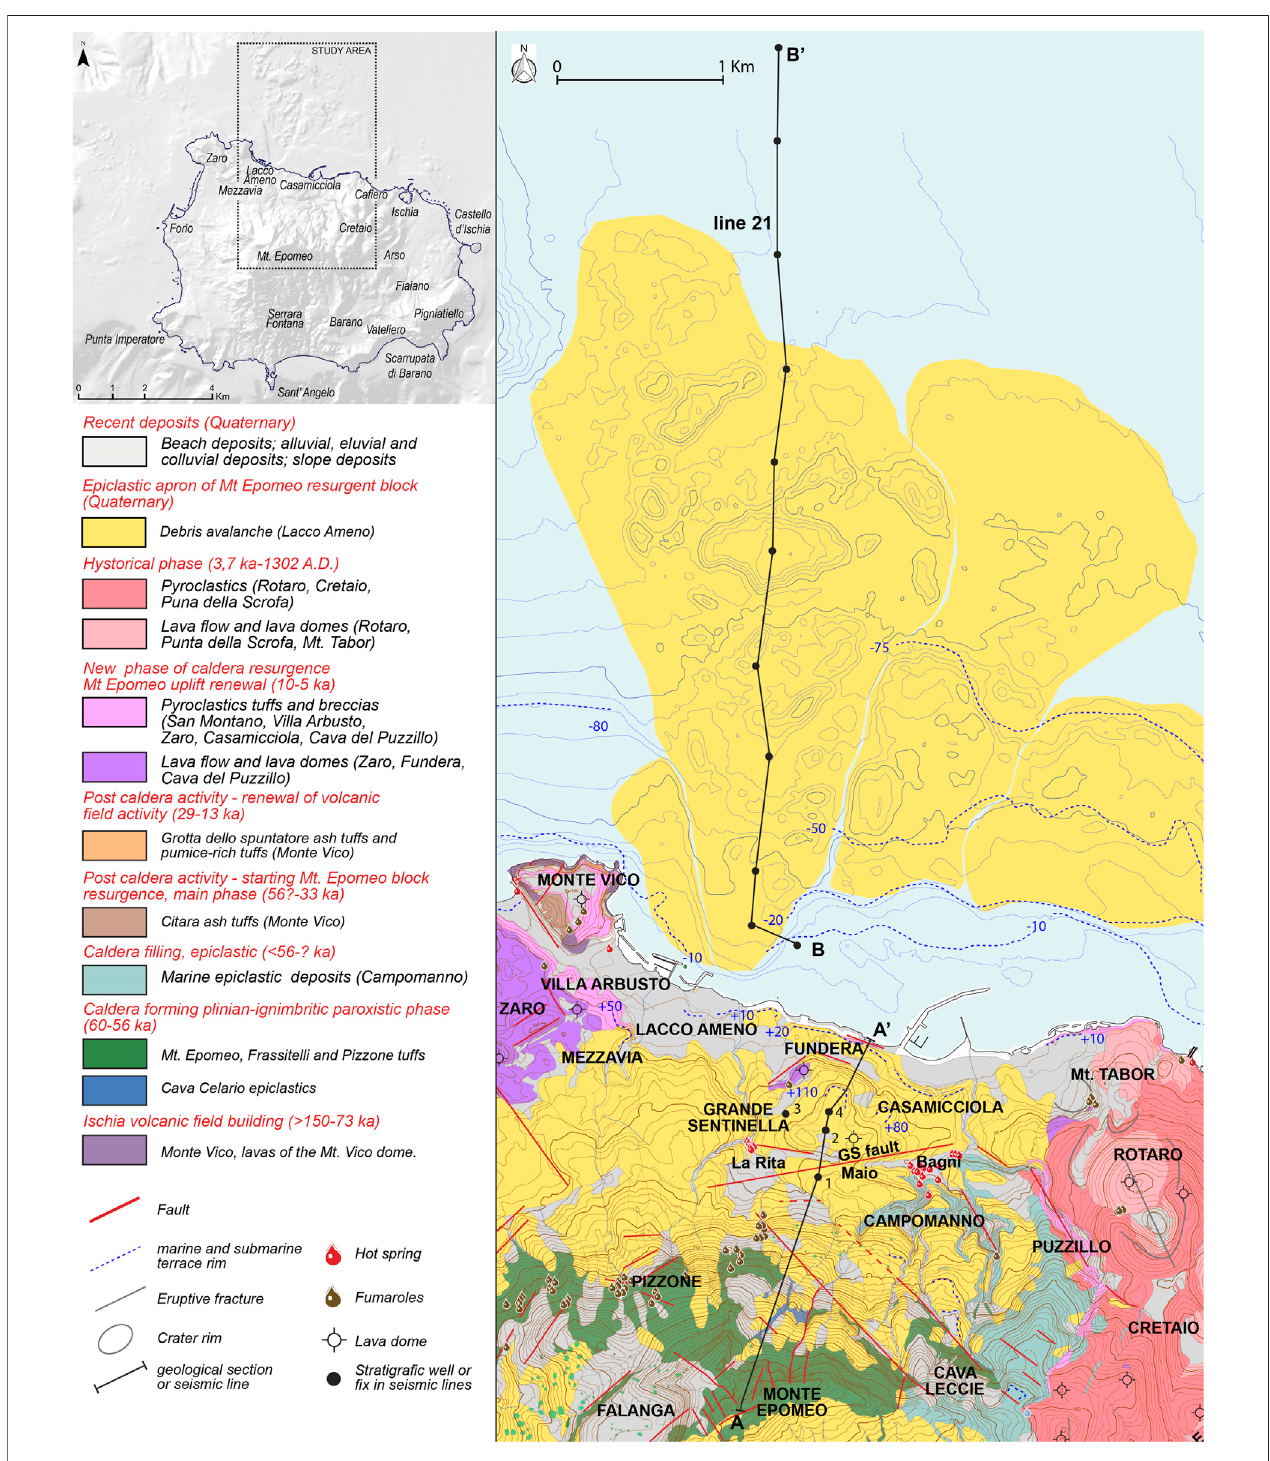
FIGURE 2 | Geological sketch of the northern sector of Ischia Island (Sbrana et al., 2018, modi fi ed).